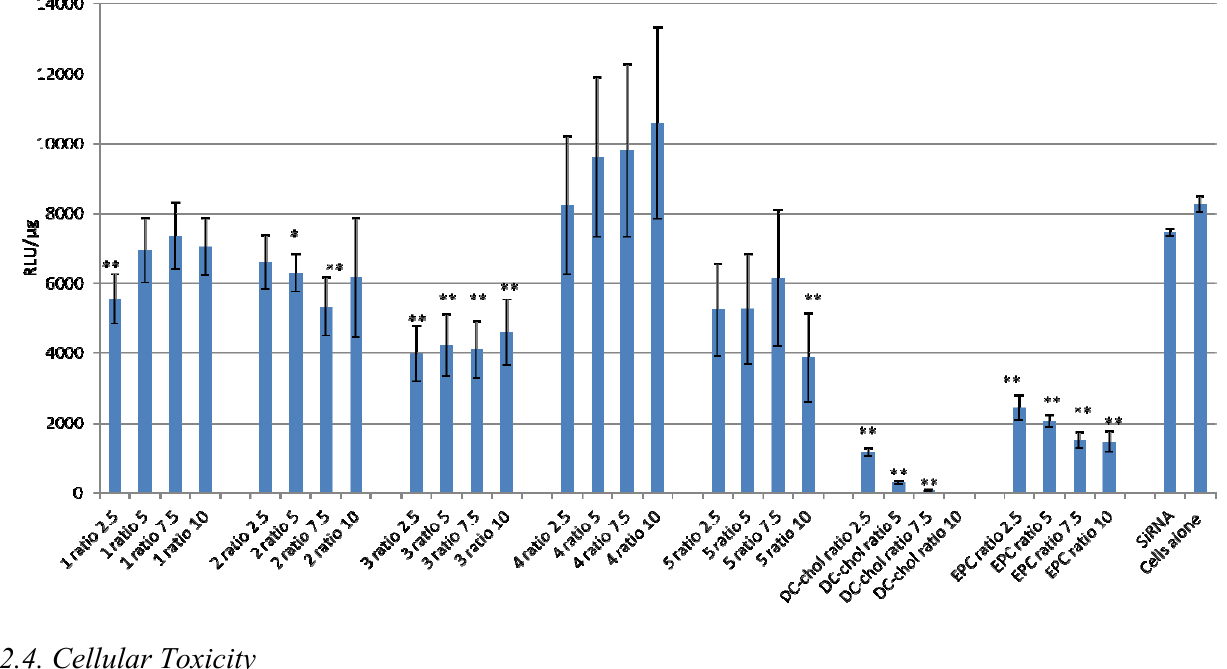
Figure 4. Luciferase knockdown for carotenoid lipoplex formulations, 1 – 5 , and controls DC-Chol and EPC, 48 h after transfection with various N/P (+/ − ) molar charge ratios. Data are expressed as relative light units (RLU)/µg of protein. Data are the average of three experiments, each performed in triplicate (n = 9). Data are expressed as mean ±